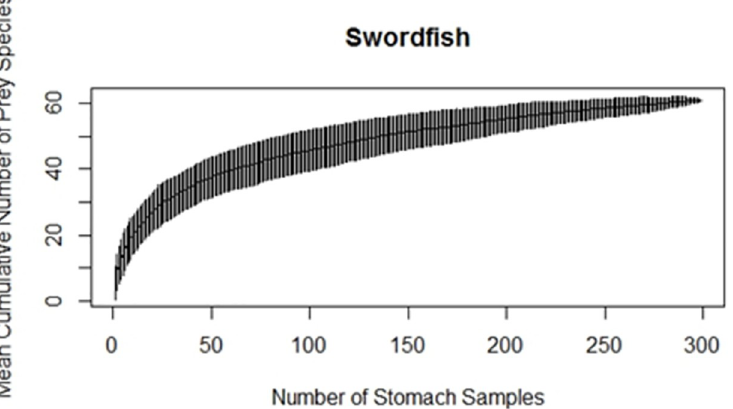
Fig 3. Cumulative prey curve (rarefaction curve) for swordfish (prey identified at the lowest possible taxonomic level).